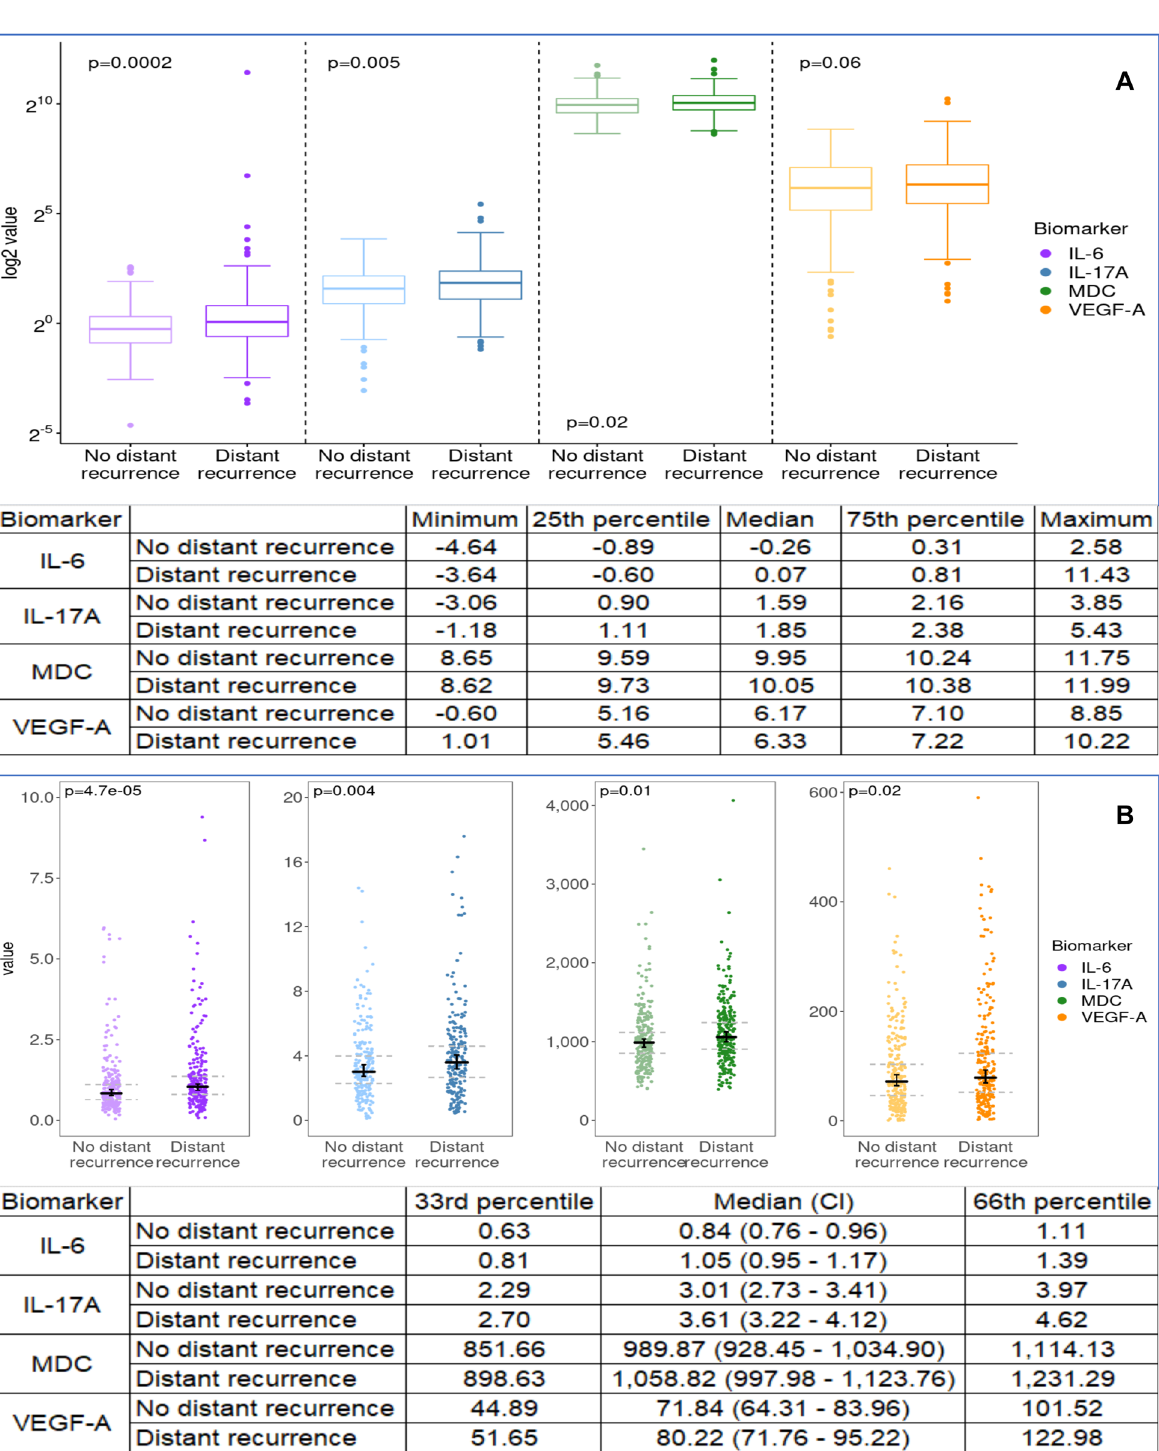
Fig. 3 Blood levels of IL-6, IL-17A, MDC/CCL22, and VEGF-A. Box plots and actual values of log2value ( A ) for IL-6, IL-17A, MDC/CCL22, and VEGF-A in cases with distant recurrence compared with controls without distant recurrence. Dot plots and actual values of raw values ( B ) for IL-6, IL-17A, MDC/CCL22, and VEGF-A in cases with distant recurrence compared with controls without distant